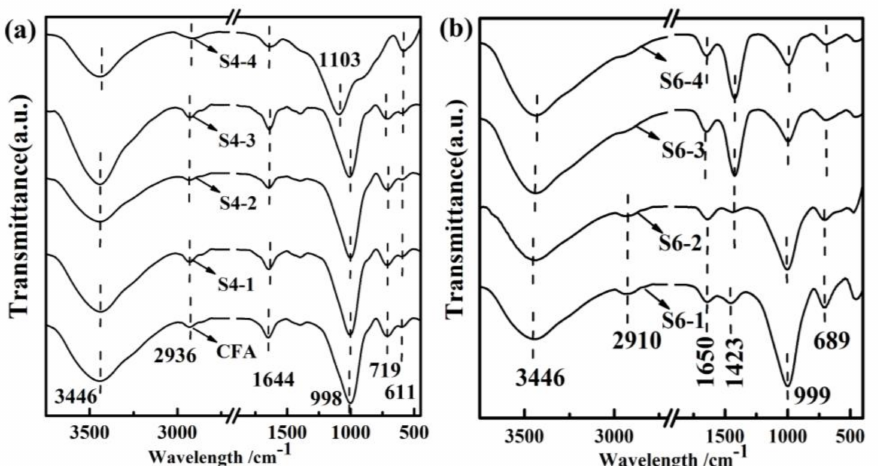
Figure 3. FTIR spectra of ( a ) CFA, and ( b ) alkali calcinated slags after contact with water. CFA was dried at 105 ◦ C for 48